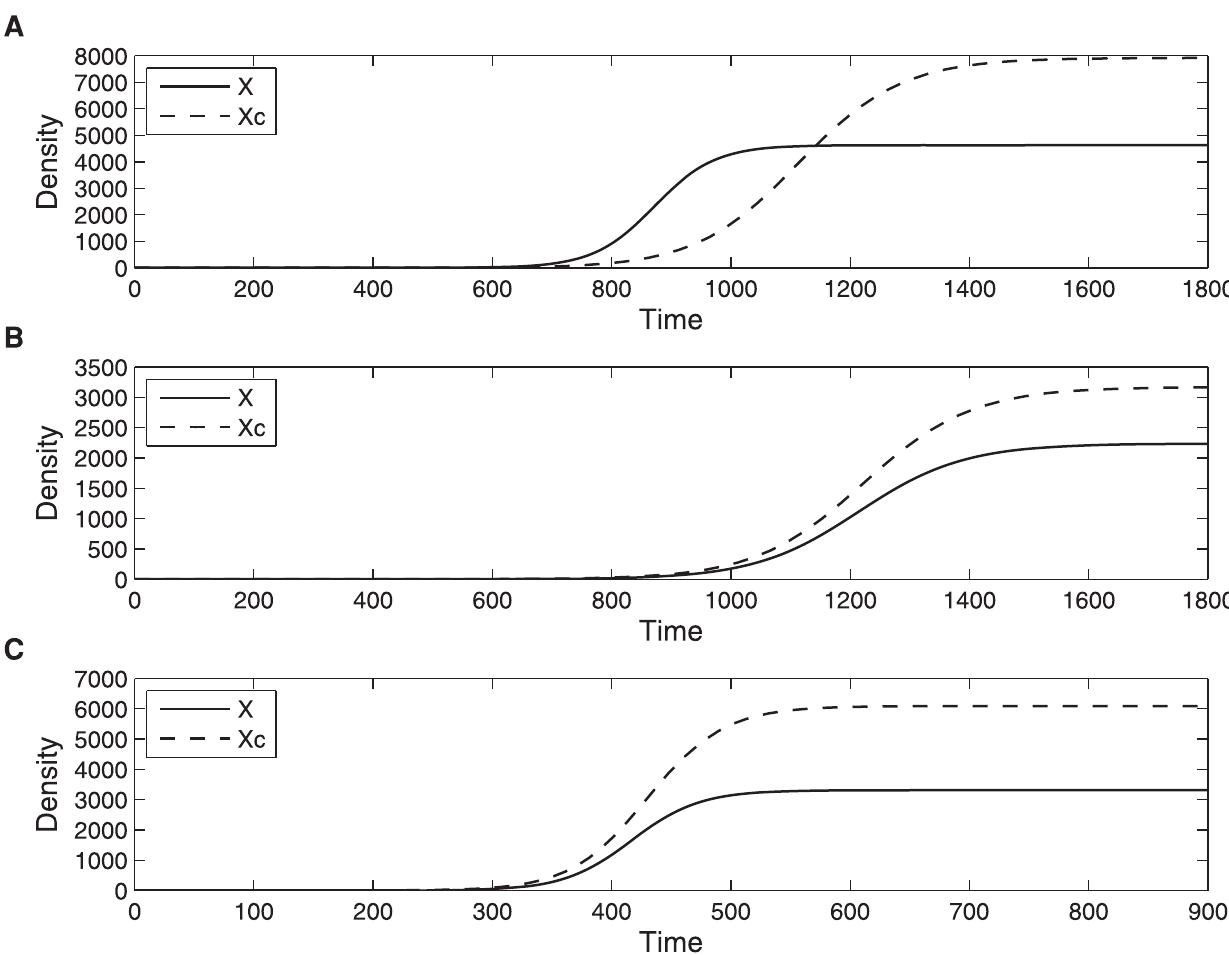
=0.009, b xy = b yx =0.001; C . r y =0.03, c ~ 1 and c